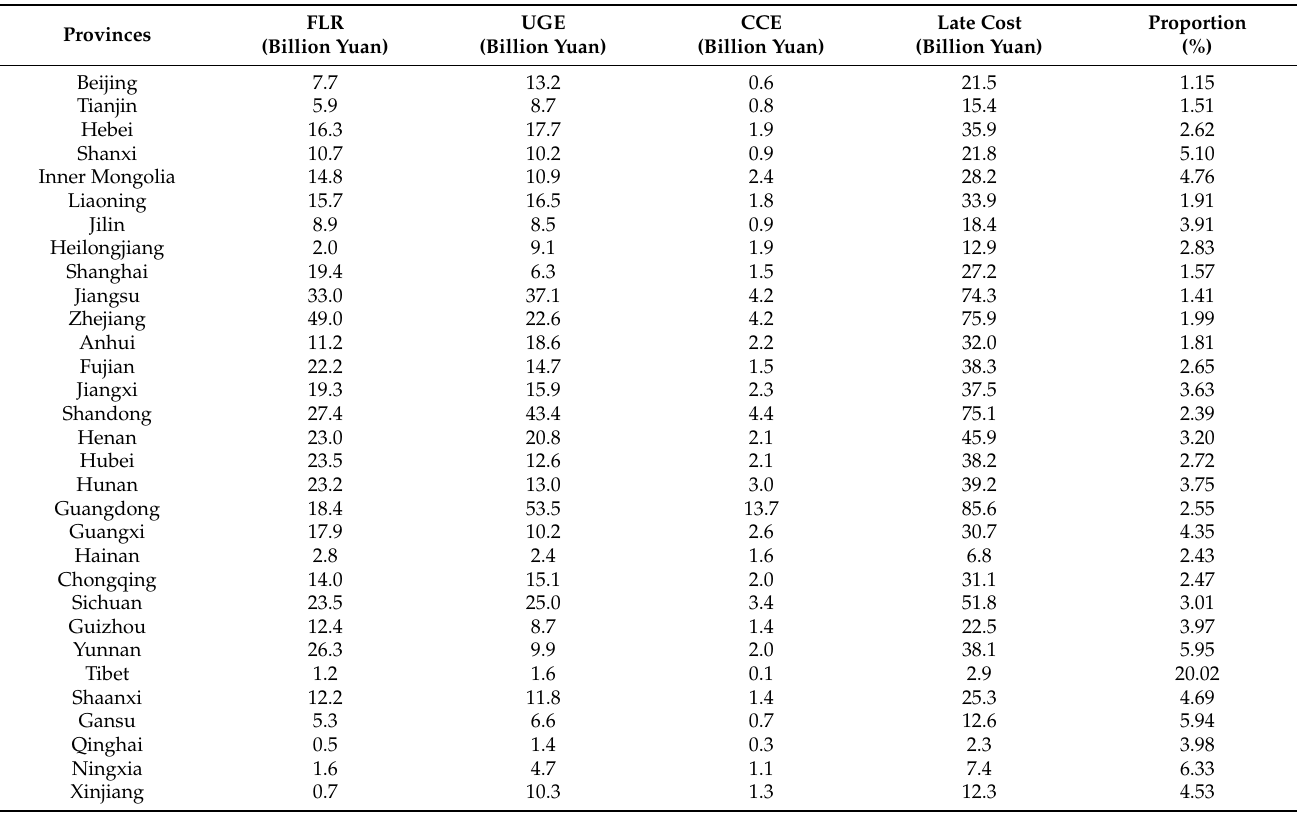
Table 3. The cost of increasing the fiscal ecological service function of land in 31 provinces from 2003 to